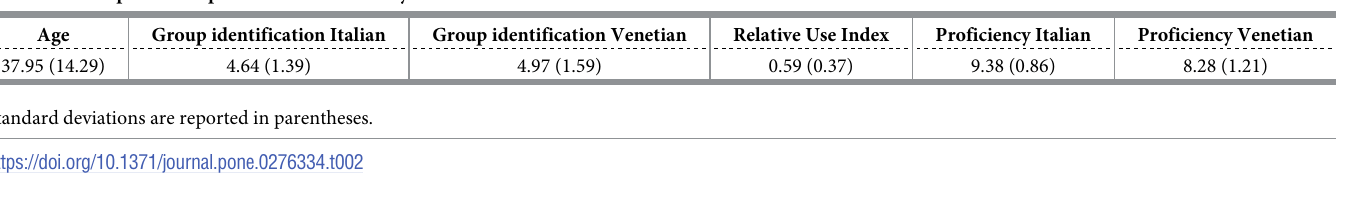
Table 2. Participant descriptive variables for